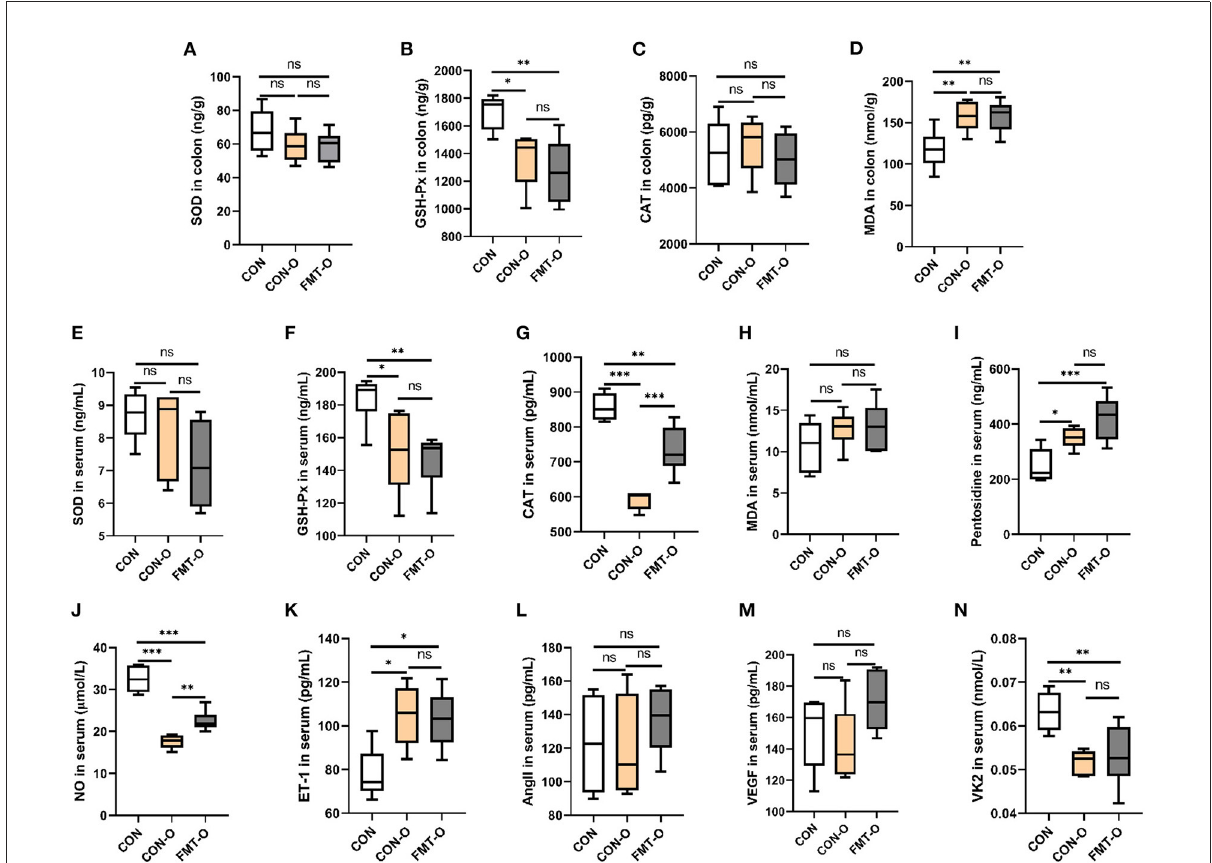
FIGURE4 Intestinal aging-related factors imbalance was found in older mice, which was transferable by fecal microbiota transplantation. The changes of aging-related factors in colon and serum (A–I) . The changes of vascular endothelial function-related factors in serum (J–N) . SOD, superoxide dismutase; GSH-Px, glutathione peroxidase; CAT, catalase; NO, nitric oxide; ET-1, endothelin-1; AngII, angiotensinII; VEGF, vascular endothelial growth factor; VK2, vitmain k2, respectively. CON, natural diet; HS, 8% salt diet; FMT-HS, gut microbiota of HS group mice transplanted to CON group mice. All data are expressed as mean ± standard error (SEM). One-way ANOVA with Tukey post hoc test was conducted. * p < 0.05, ** p < 0.01, *** p < 0.001; ns, no